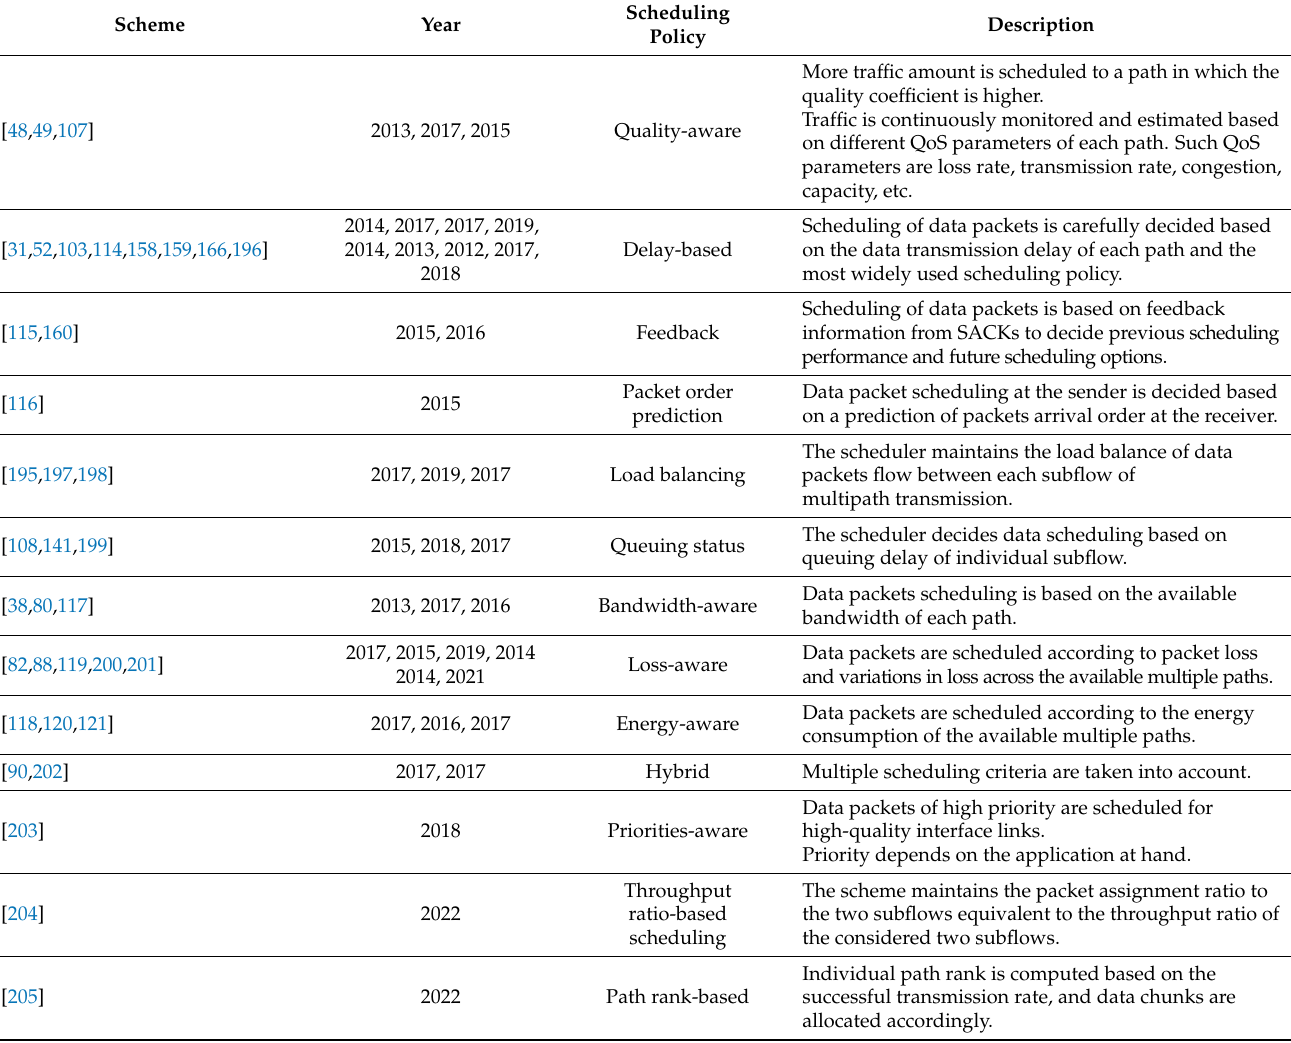
Table 3. Summary of multipath